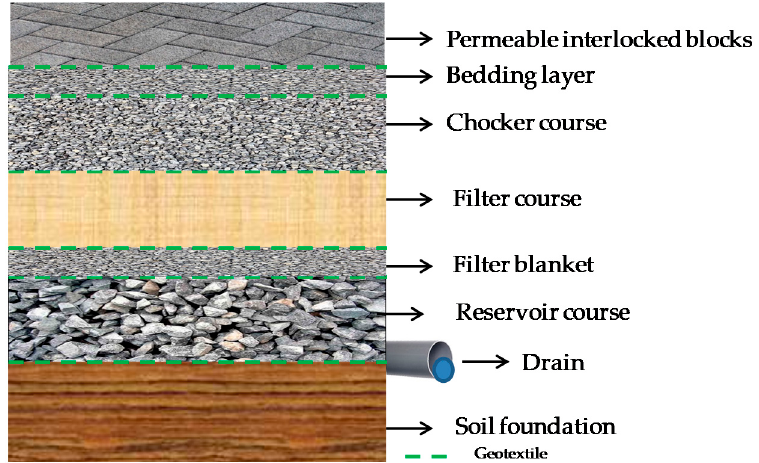
Figure 1. Cross section of a permeable interlocking concrete pavement. Table 1. Permeable interlocking concrete pavement layers.